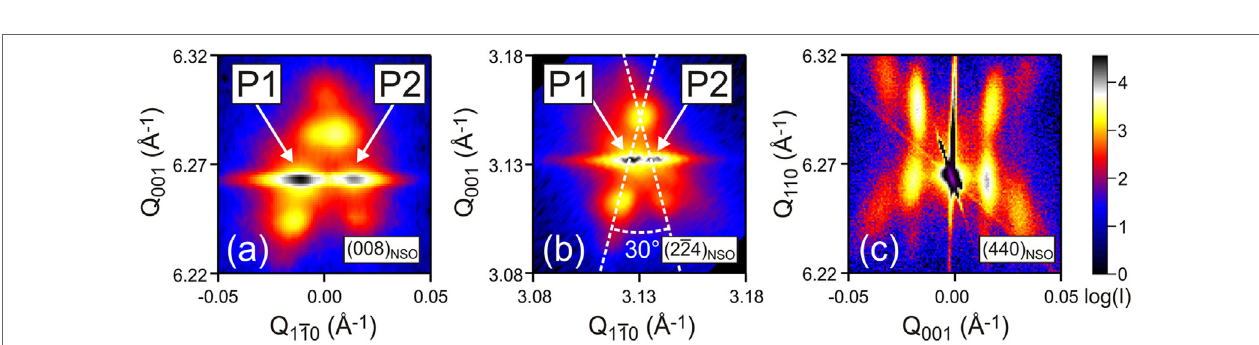
FigUre 9 | In-plane grazing incidence X-ray diffraction of the 28 nm thick K 0.9 Na 0.1 NbO 3 film on (110) NdScO 3 (NSO) substrate in the vicinity of the (008) NSO (a) and (224) NSO (b) substrate Bragg reflection. (c) Out-of-plane reciprocal space map in the vicinity of (440) NSO of the same film.